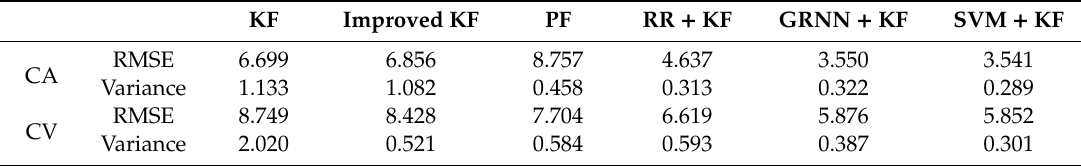
Figure 7. Simulation results in the turning region of trail 3. Table 4. Simulation results of different algorithms in the turning region of trail 3 with 100 rounds.